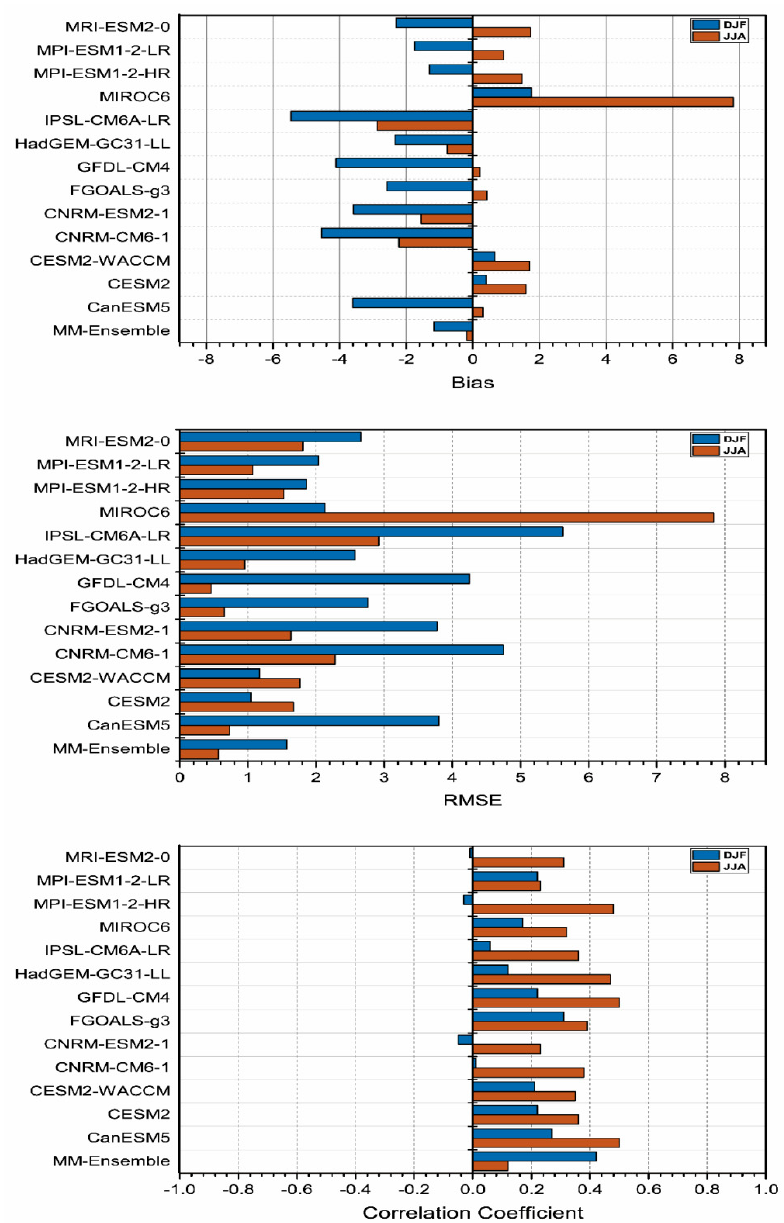
Figure 9. Bias, RMSE, and correlation coefficient for models and MM-Ensemble based on CRU datasets in JJA and DJF seasons of 1970–2014 over Pakistan. The brown-colored legend key identifies the JJA metrics while the dark blue color identifies DJF season metrics.